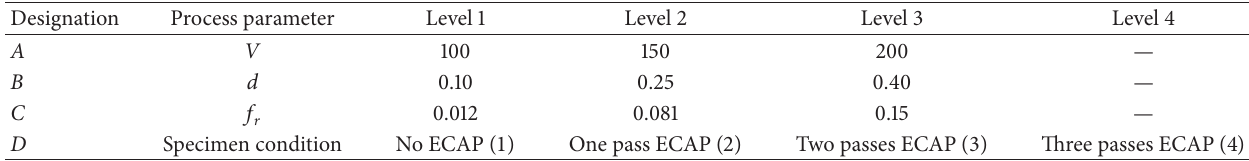
Table 2: The cutting parameters and their levels used in the Box-Behnken